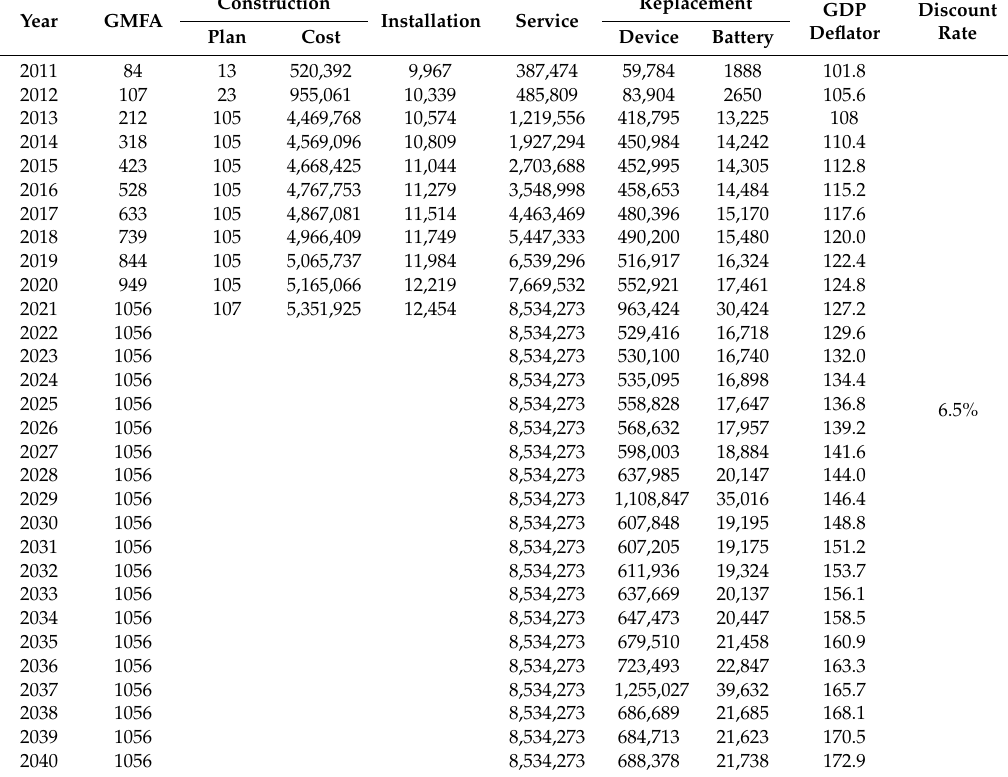
Table A3. Cost detail of the GMFA (unit: